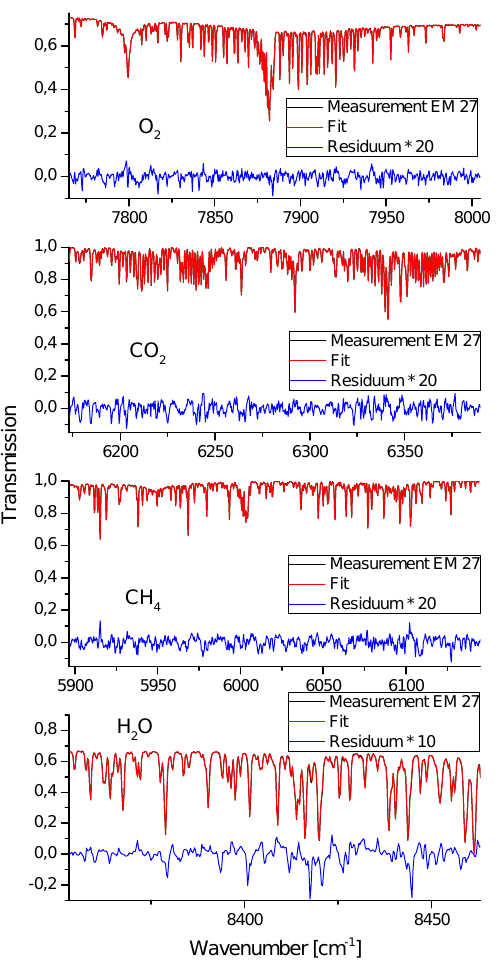
Figure 4. Spectral windows used during the retrieval for the dif- ferent species. The fit is in accordance with the measurement, the residual, which has been multiplied with a factor of 10 for H 2 O and 20 for the other species, is small.